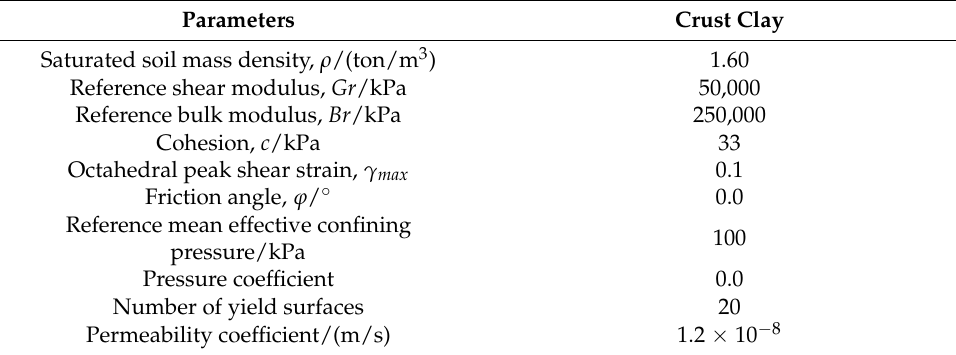
Table 2. Constitutive model parameters of the crust